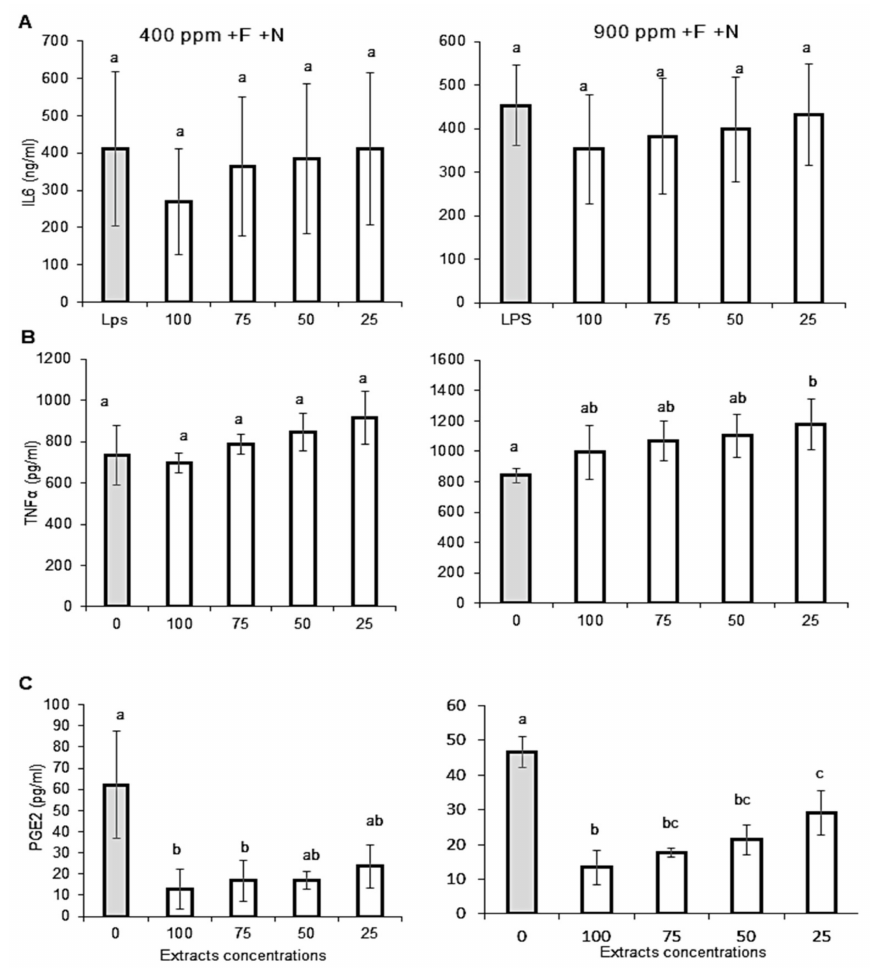
Figure 6. Effect of Micro-Tom tomato fruits extracts on nitric oxide production and scavenging capacity. Fruits samples were collected from hydroponically grown plants (Control condition +F/+N) under ambient (400 ppm) or elevated (900 ppm) atmospheric CO 2 concentrations. ( A ) Interleukin- 6 (IL-6), ( B ) Tumour necrosis factor alpha, ( C ) Prostaglandin E2 (PGE-2) levels were measured by ELISA in the supernatant of J774 macrophages stimulated with lipopolysaccharide (LPS) and interferon gamma (IFN γ )Error bars show ± SD ( n = 3).The grey bars refer to control cells activated by LPS/interferon. Means within each condition with the same letter are not statistically different according to one-way ANOVA followed by post hoc Tukey test ( p <